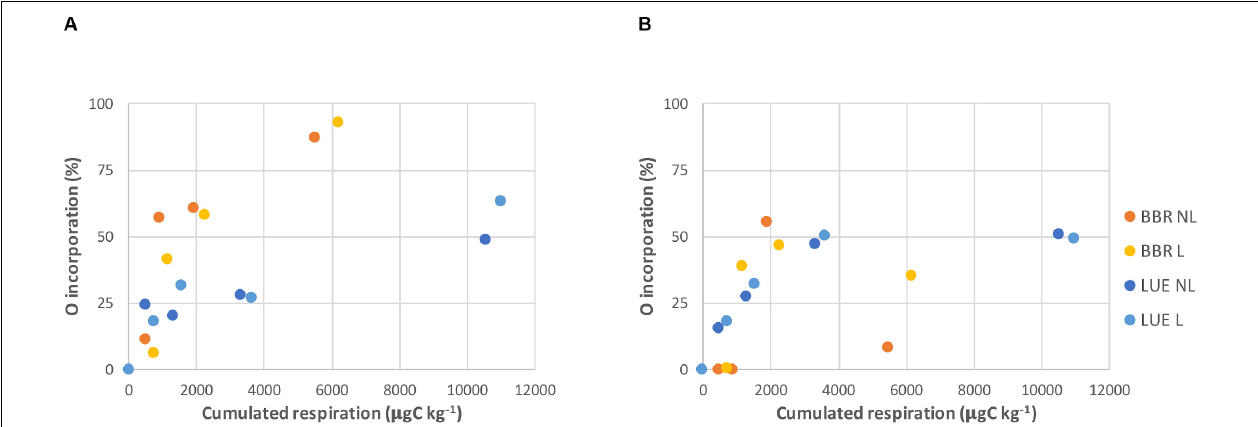
FIGURE 4 | Oxygen incorporation from labeled water into the available (P res ; A ) and microbial P (P mic ; B ) in Bad Brückenau (BBR) and Lüss (LUE) soils against cumulated respiration. NL, non-amended; L, leaf